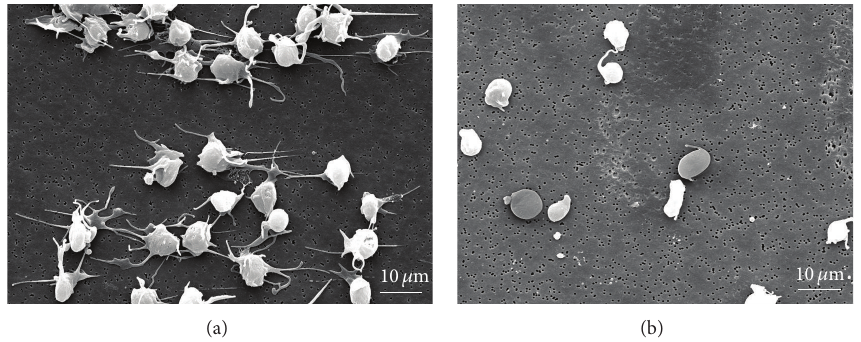
Figure 1: Scanning Electron Microscopy showing activated (a) and nonactivated (b) platelets in PRC.